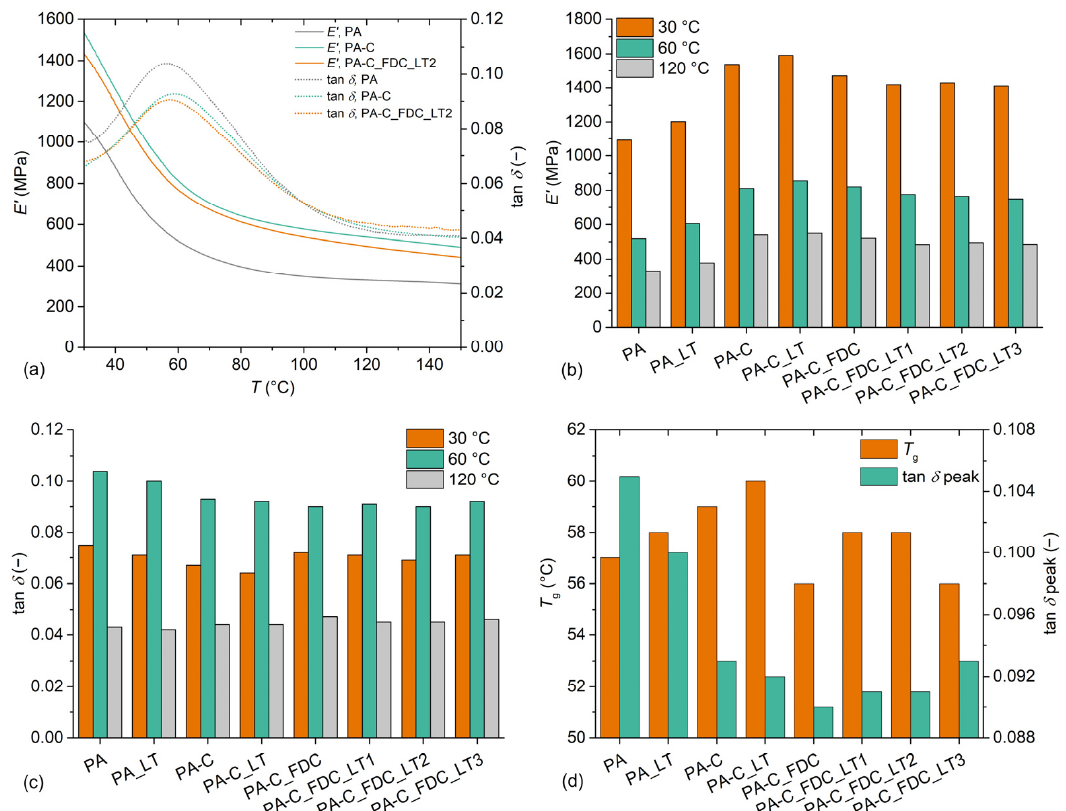
Figure 6. Dynamic mechanical properties of samples: ( a ) E ′ and tan δ as a function of the temperature of representative samples; ( b ) E ′ of samples at 30 °C, 60 °C and 120 °C; ( c ) tan δ of samples at 30 °C, 60 °C and 120 °C; ( d ) T g and corresponding tan δ values of samples.